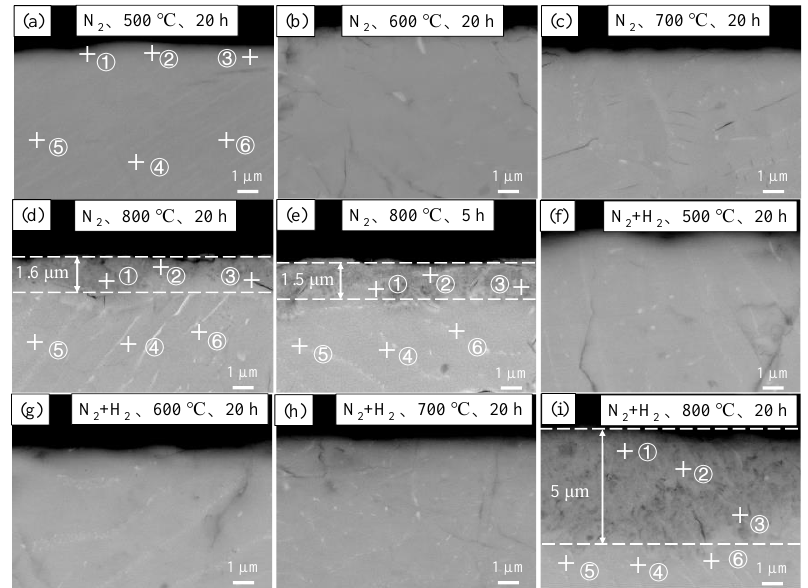
Figure 2. Surface SEM images of zirconium hydride with nitride film ( a ) N 2 , 20 h, 500 °C; ( b ) N 2 , 20 h, 600 °C; ( c ) N 2 , 20 h, 700 °C; ( d ) N 2 , 20 h, 800 °C; ( e ) N 2 , 5 h, 800 °C; ( f ) N 2 + H 2 , 20 h, 500 °C; ( g ) N 2